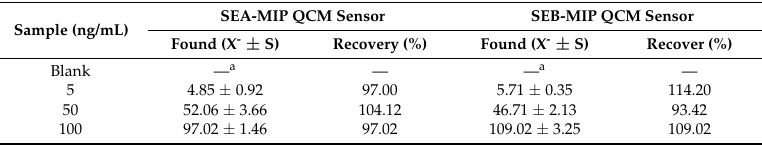
Table 2. The observed concentrations and % recovery values of SEA-MIP and SEB-MIP sensors for spiked milk samples, — a indicates not detectable concentration, reproduced with permission from [112].